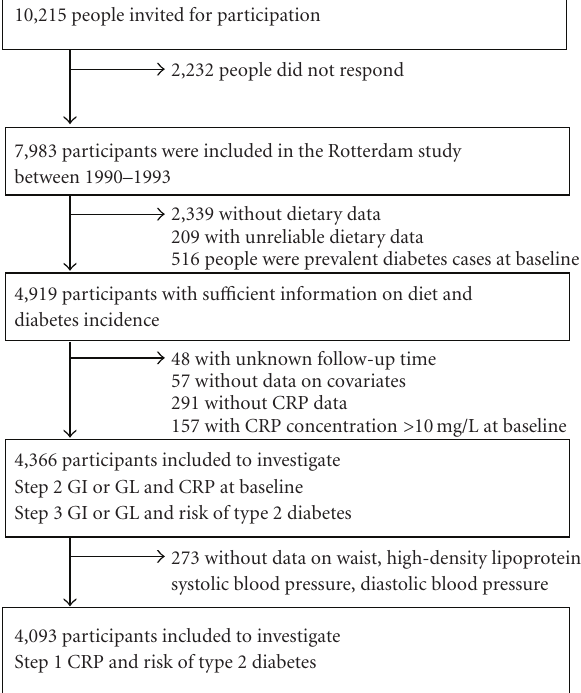
Figure 1: Flow diagram for selection of participants to investigate whether glycemic index (GI) or glycemic load (GL) is associated with C- reactive protein (CRP) and with risk of type 2